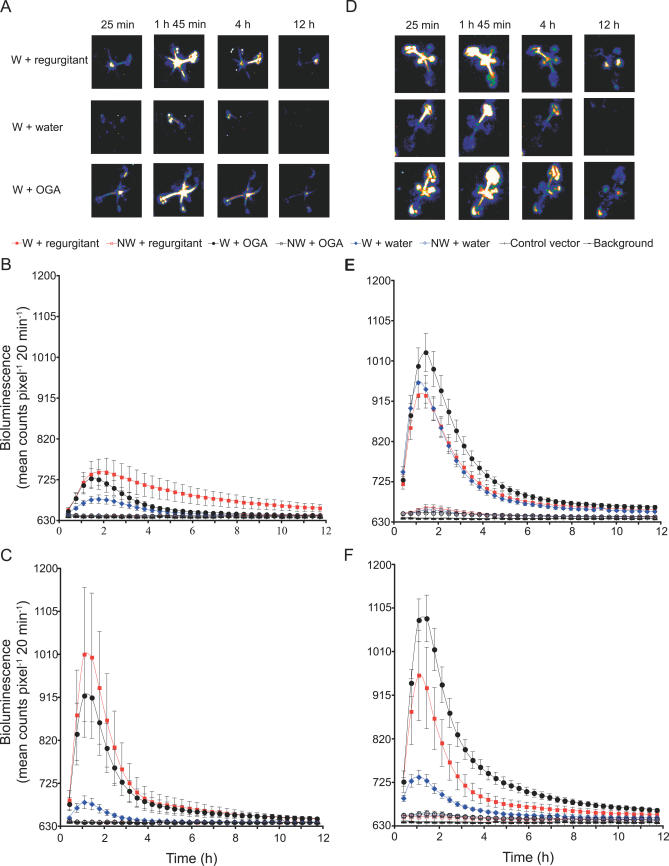
In Vivo Monitoring of RWR Gene Induction upon Addition of Biotic ElicitorsOne leaf per plant was either NW or wounded (W) and then treated with oligouronides (OGA), IR, or double-distilled H2O.(A) Image of an individual PERF18:LUC #3 transgenic plant over time.(B) Local expression in the treated leaves of PERF18:LUC #3 transgenic plants. Data are means of n = 9 ± SEM.(C) Systemic expression of PERF18:LUC #3 plants monitored in the shoot apex. Data are means of n = 9 ± SEM.(D) Image of an individual PCAF1L:LUC #2 transgenic plant over time.(E) Local expression in the treated leaves of PCAF1L:LUC #2 transgenic plants. Data are means of n = 12 ± SEM.(F) Systemic expression of PCAF1L:LUC #2 plants monitored in the shoot apex. Data are means of n = 12 ± SEM.